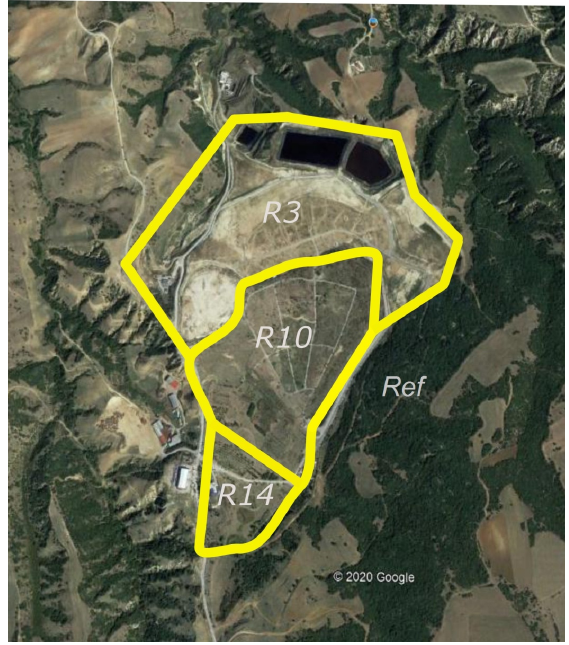
Figure 1. Map of the reclaimed areas of different ages (R3: 3-yrs, R10; 10-yrs and R14; 14-yrs) and the reference site (Ref).